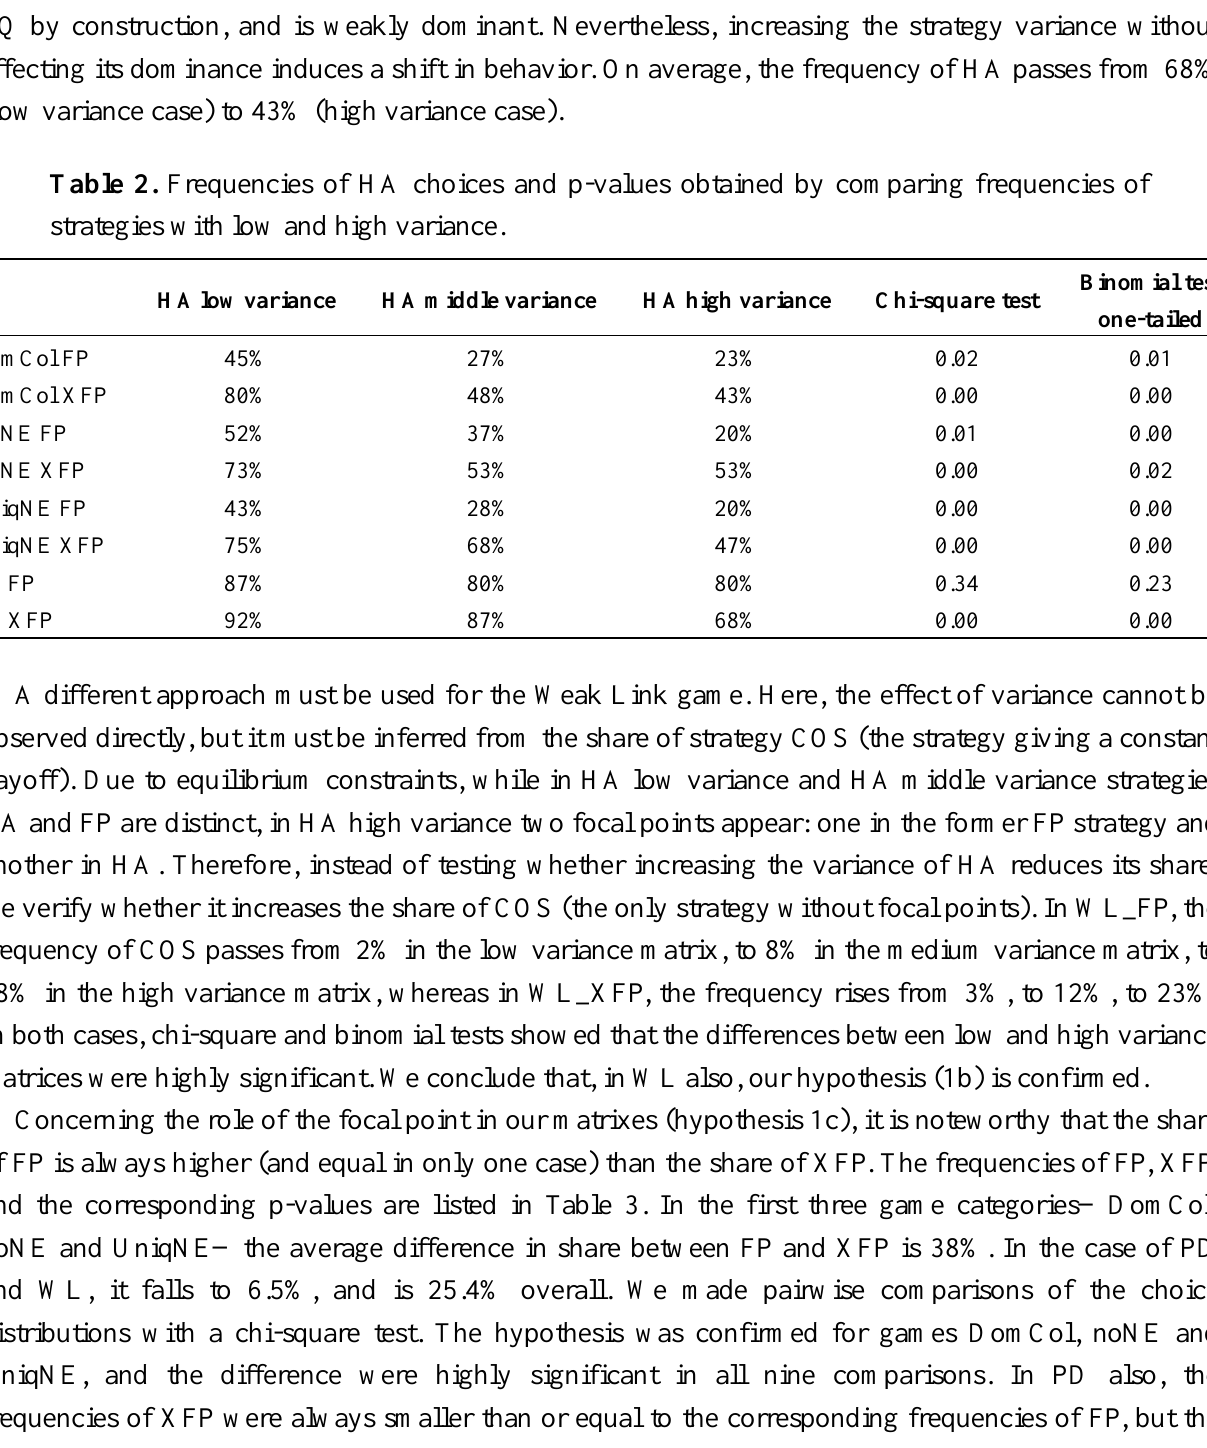
Table 2. Frequencies of HA choices and p-values obtained by comparing frequencies of strategies with low and high variance. HA low variance HA middle variance HA high variance Chi-square test